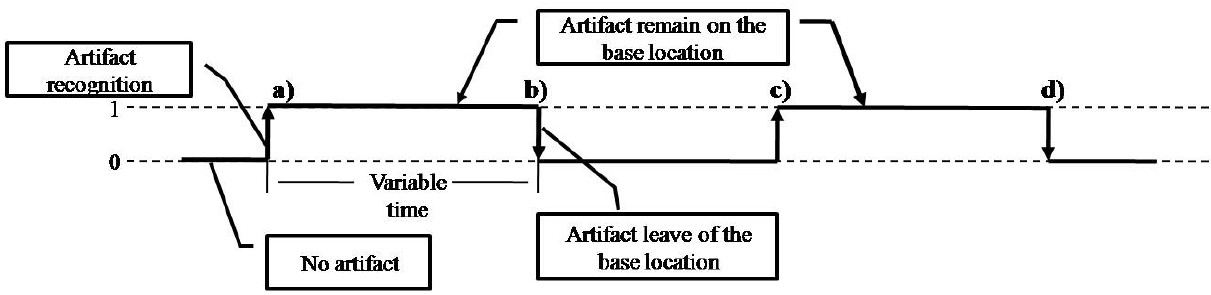
Figure 2. Artifact’s behavior representation (or roaming